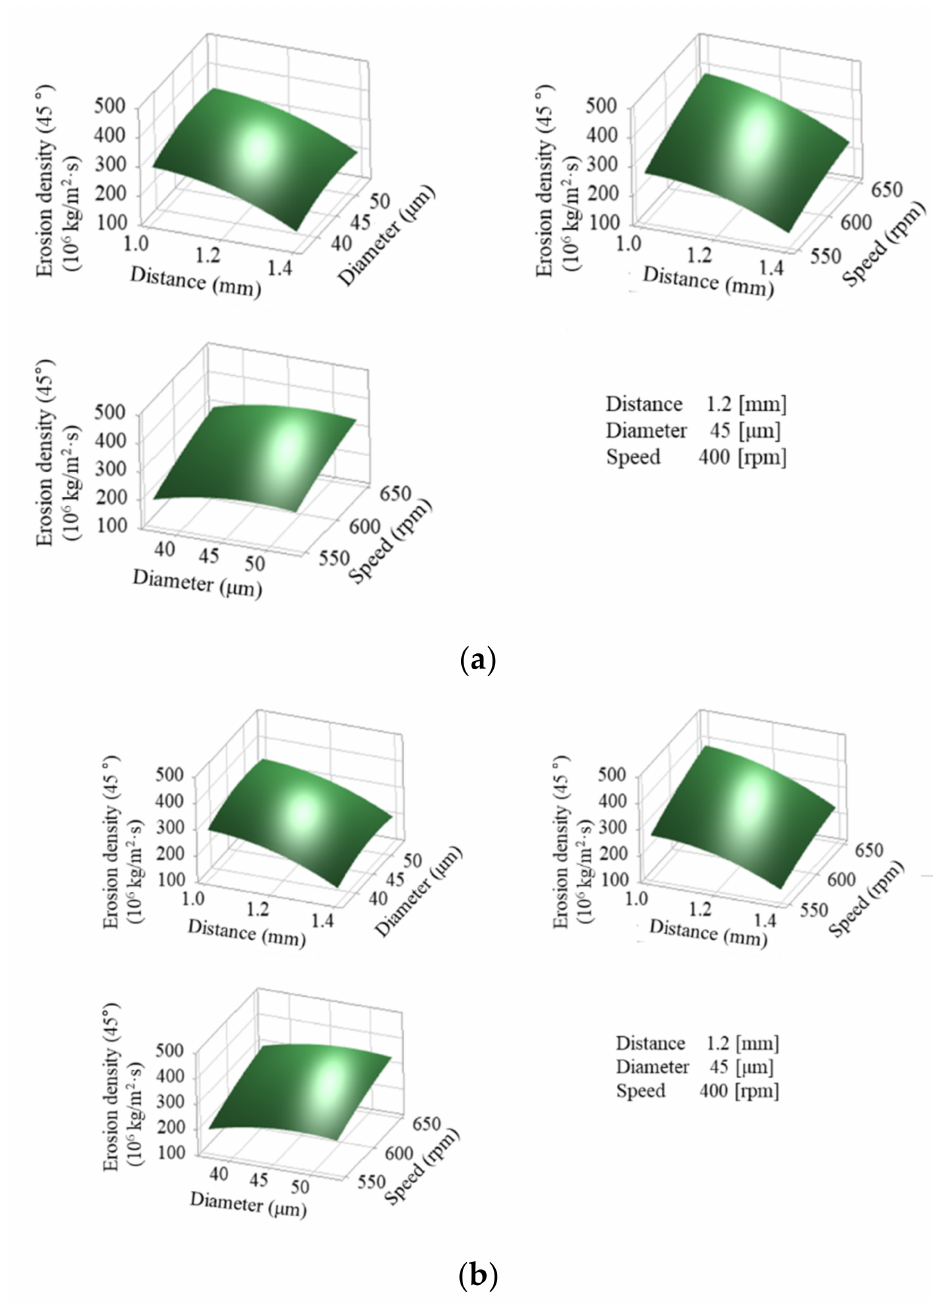
Figure 10. The response surface plots for the erosion rate density: ( a ) erosion rate density at 45 ◦ locations of the wear map; ( b ) erosion rate density at 315 ◦